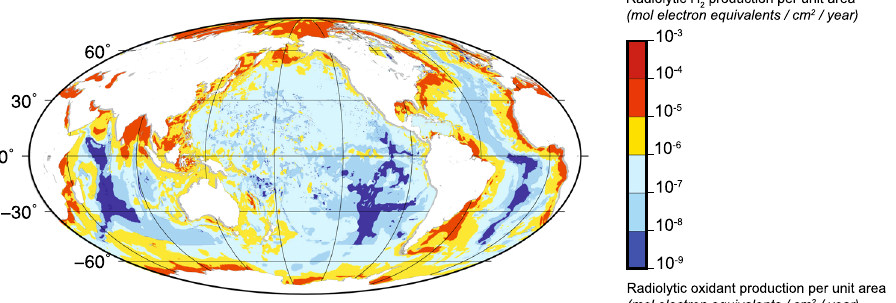
Fig. 3 Global distribution of production rates of radiolytic H 2 and radiolytic oxidants in marine sediment. Rates are expressed in mol electron equivalents/cm 2 /year. In electron equivalents, water radiolysis produces H 2 and oxidized chemicals at equal rates. Although abyssal clay has a volumetric radiolytic production rate ∼ an order of magnitude higher than the volumetric rate for continental-margin sediment types, the sediment layer that blankets open-ocean regions is much thinner and consequently has much lower vertically integrated radiolytic production than the sediment of continental